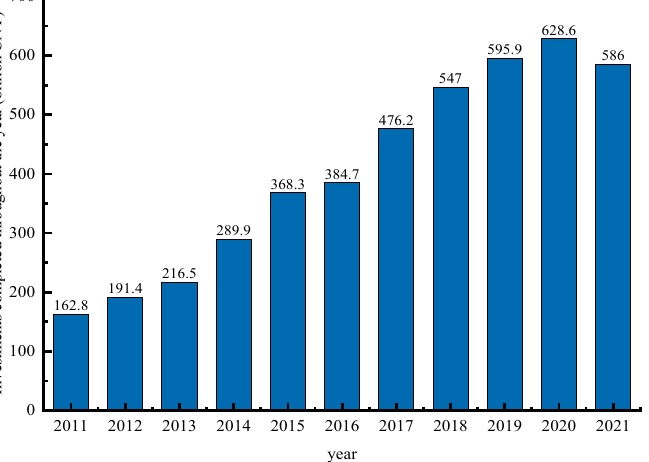
Figure 1. The completed construction investment of subways in mainland China from 2011 to 2021. At present, the research on flood disasters in subway stations mainly focuses on three aspects: the formation mechanism and influencing factors of flood disasters in subway stations [11–13], the flood vulnerability assessment of subway stations, and the simula- tion analysis of the flood disaster model of the subway station [14–16]. The simulation analysis of the flood disaster model of the subway station includes physical experiment research and numerical simulation research. In terms of physical experiments, Inone